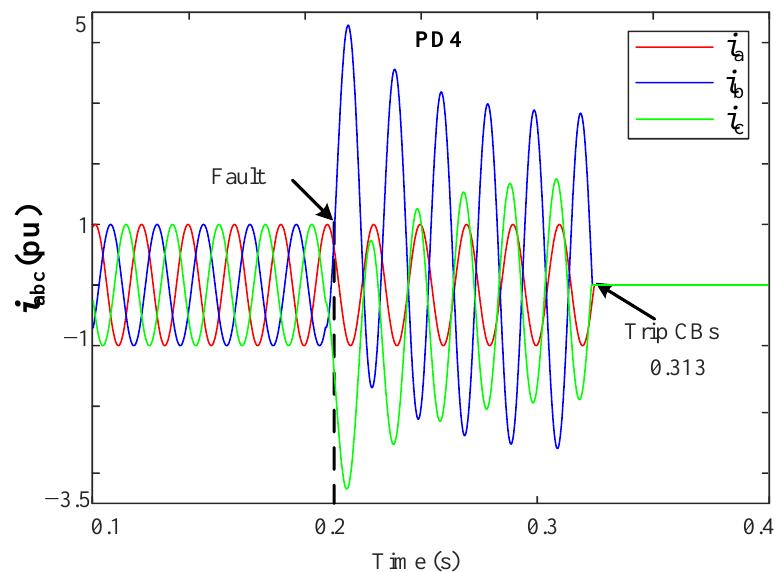
Figure 13. i abc currents for the DR during a 2PH fault at DL2, phases b and c . Figure 13. 𝑖 𝑎𝑏𝑐 currents for the DR during a 2PH fault at DL2, phases b and c . Furthermore, one of the difficulties in distribution network fault diagnosis is the Furthermore, one of the difficulties in distribution network fault diagnosis is the de- detection of different fault impedances, so in this regard the two protection methods had tection of different fault impedances, so in this regard the two protection methods had been tested considering different fault resistances, fault types, and fault locations. For been tested considering different fault resistances, fault types, and fault locations. For ex- example, when a 1PH-G (AG) fault with a fault resistance of ( r = 5 Ω ) occurs in L3 at 0.2 s, ample, when a 1PH-G (AG) fault with a fault resistance of ( 𝑟 = 5 Ω) occurs in L3 at 0.2 s, it has been noticed that the MSOGI-THD method clears the fault at 0.3095 s while the DR it has been noticed that the MSOGI-THD method clears the fault at 0.3095 s while the DR method clears the fault at 0.3152 s. Figure 14 shows the grid currents for a 1PH-G fault at method clears the fault at 0.3152 s. Figure 14 shows the grid currents for a 1PH-G fault at L3 for both methods. In all cases, the proposed method clears the fault faster than the DR L3 for both methods. In all cases, the proposed method clears the fault faster than the DR method, as shown in Figure 15. Moreover, the proposed method is compared with other method, as shown in Figure 15. Moreover, the proposed method is compared with other protection methods under the same conditions. Table 4 summarizes the tripping times and protection methods under the same conditions. Table 4 summarizes the tripping times and shows the advantages and disadvantages of the different methods. It can be stated proposed THD protection method can be a viable solution to be adopted for providing a that the proposed THD protection method can be a viable solution to be adopted for faster trip decision under various conditions when using communication lines. providing a faster trip decision under various conditions when using communication lines.